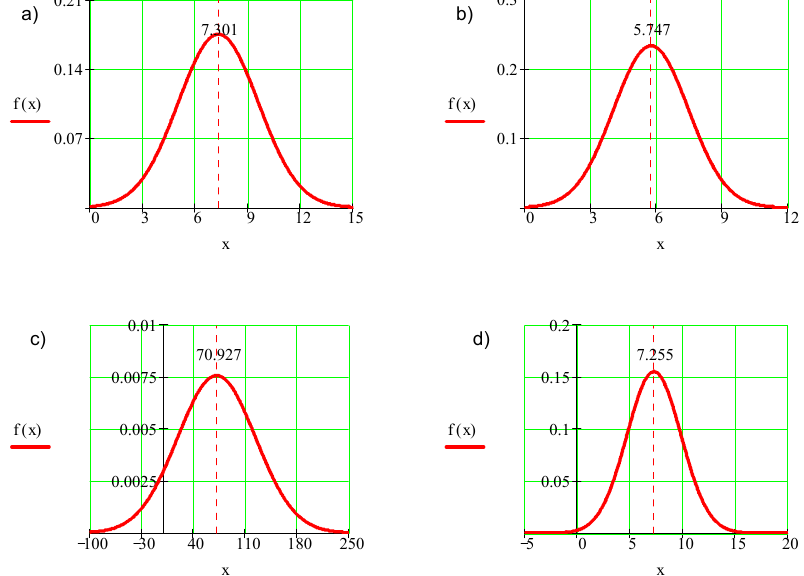
Figure 9. Normal distribution of probability density in the function of the obtained results: ( a ) height of Rms surface— Sq , ( b ) mean arithmetic surface height— Sa , ( c ) orientation of surface height— Std , and ( d ) developed ratio of surface interphasic area— Sd .